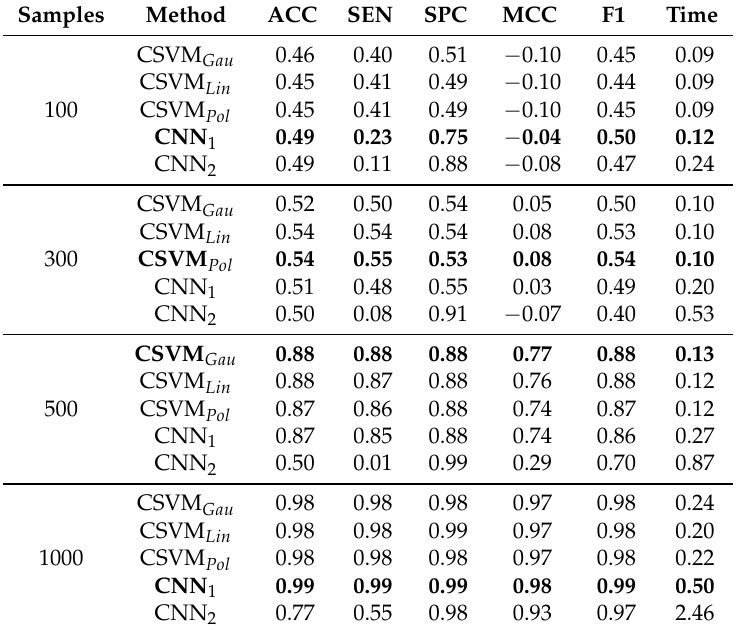
Table 3. Simulation results for convolutional methods with µ difference equals to 1SD. The time column refers to the model’s training time. The suitable model performance is highlighted in bold for each case.